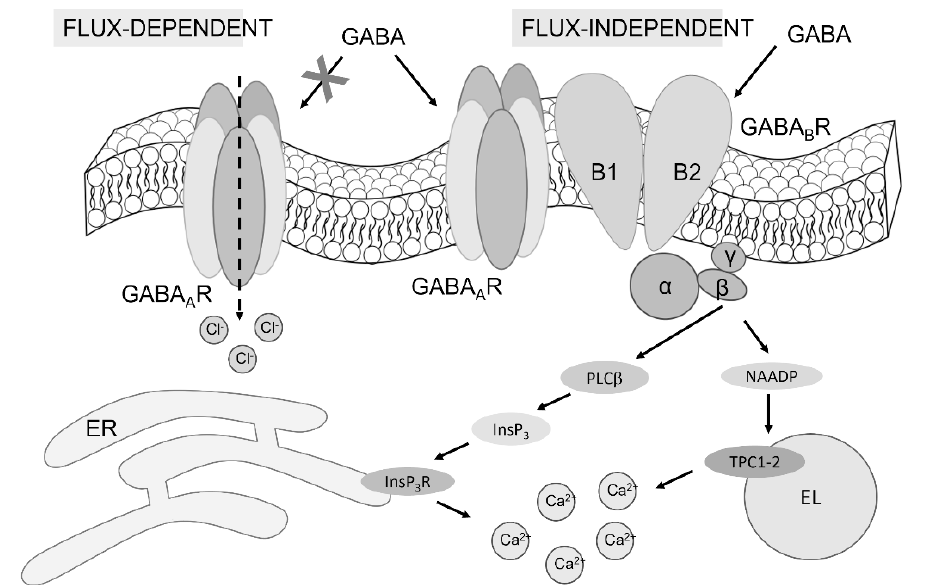
Figure 9. The mechanism of GABA-evoked intracellular Ca 2+ signals in hCMEC/D3 cells. The evidence presented in this investigation demonstrates that both GABA A and GABA B receptors support the Ca 2+ response to GABA in hCMEC/D3 cells. GABA A receptors are unlikely to signal the increase in [Ca 2+ ] i in a flux-dependent manner, whereas they can operate in a metabotropic manner by interacting with GABA B receptors. This interaction leads to InsP 3 -induced Ca 2+ mobilization from the ER and NAADP-induced EL Ca 2+ release through TPCs. The following reduction in ER Ca 2+ concentrations, in turn, activates SOCE (not illustrated here).